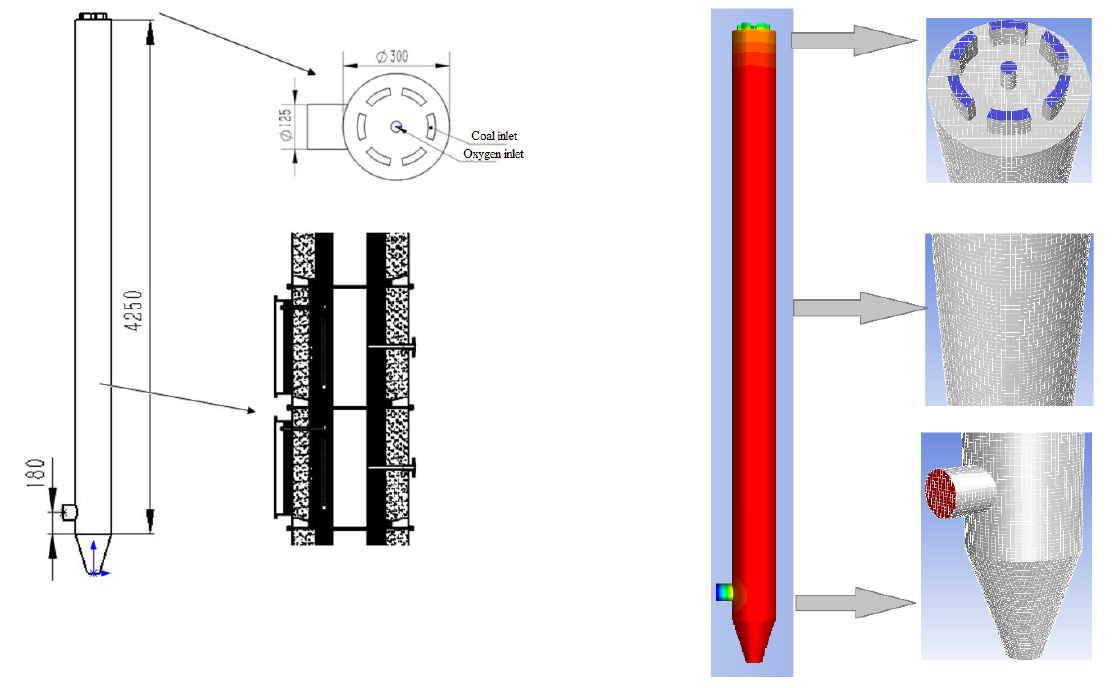
Figure 2. The schematic diagram for the meshed geometry shows a closer view of the inlet and outlet injection.